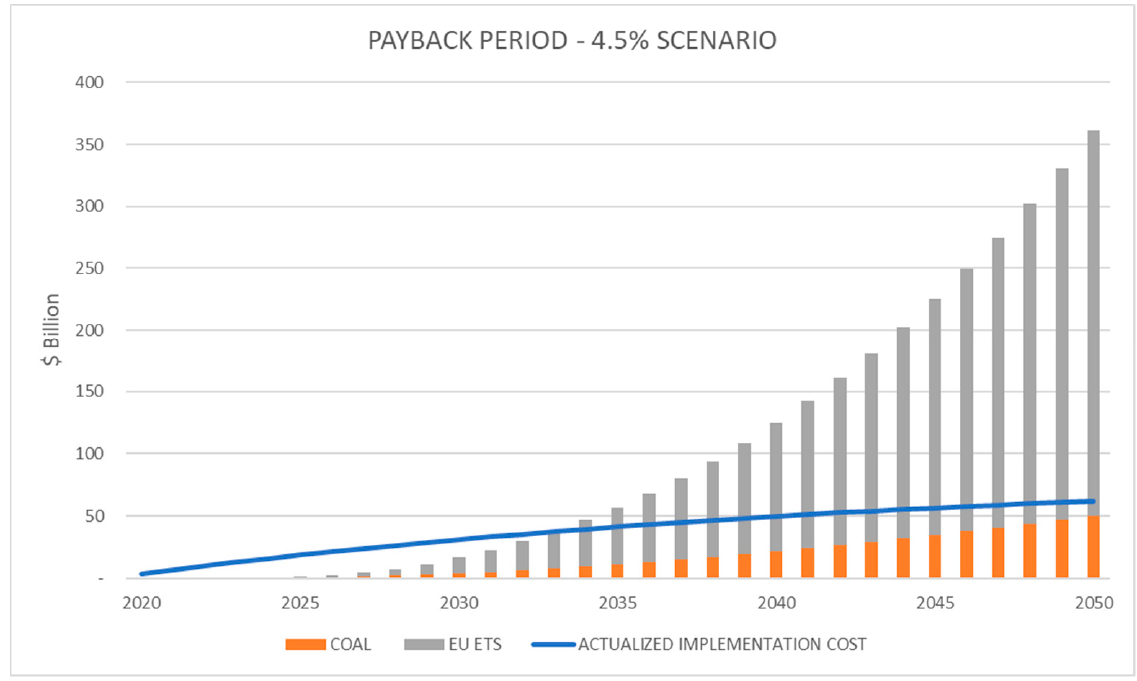
Figure 8. Payback period in the 4.5% scenario.